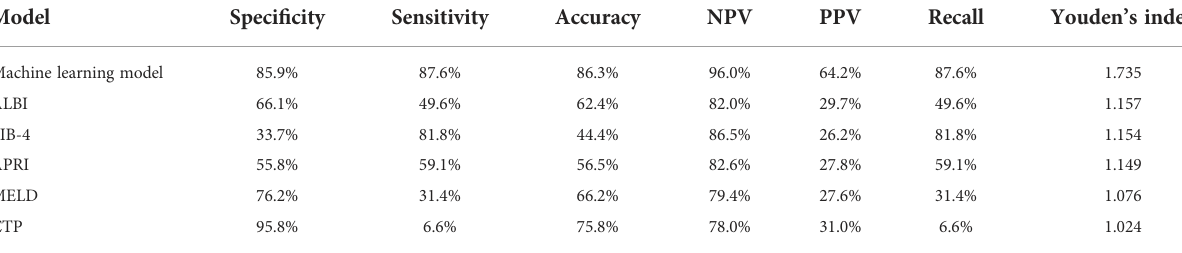
TABLE 2 Predictive power of the ML model and routine clinical models using data of the training cohort. Model